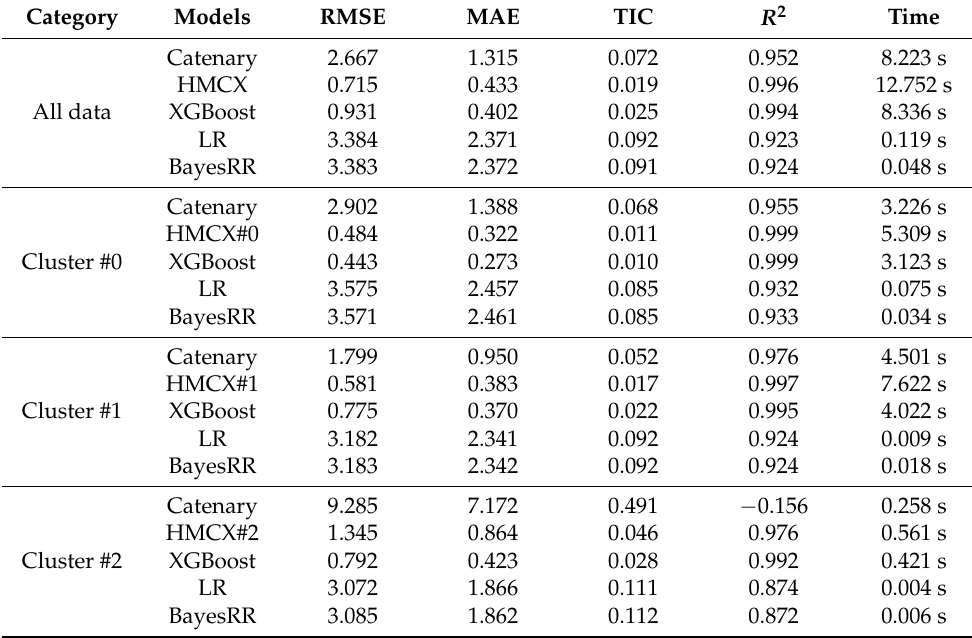
Table 6. The results of evaluation indicators for all data and the clusters n =